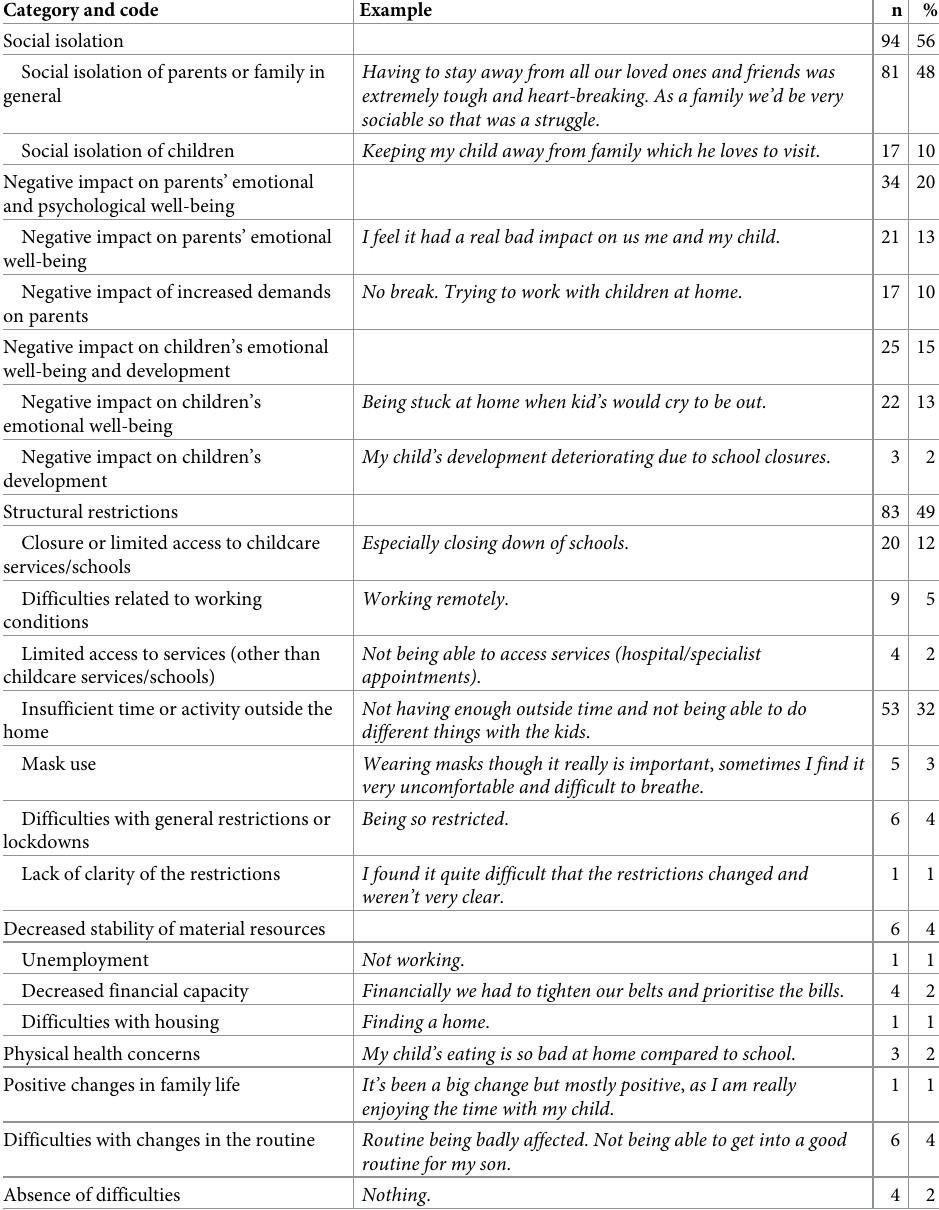
Table 2. Codes and categories within difficulties related to the Covid-19 restrictions. Category and